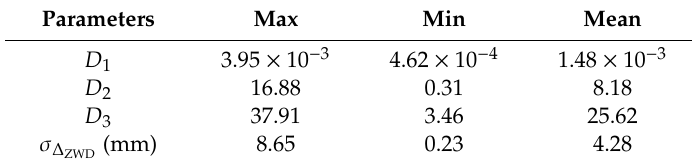
Table 1. Uncertainty values estimated from the radiosonde